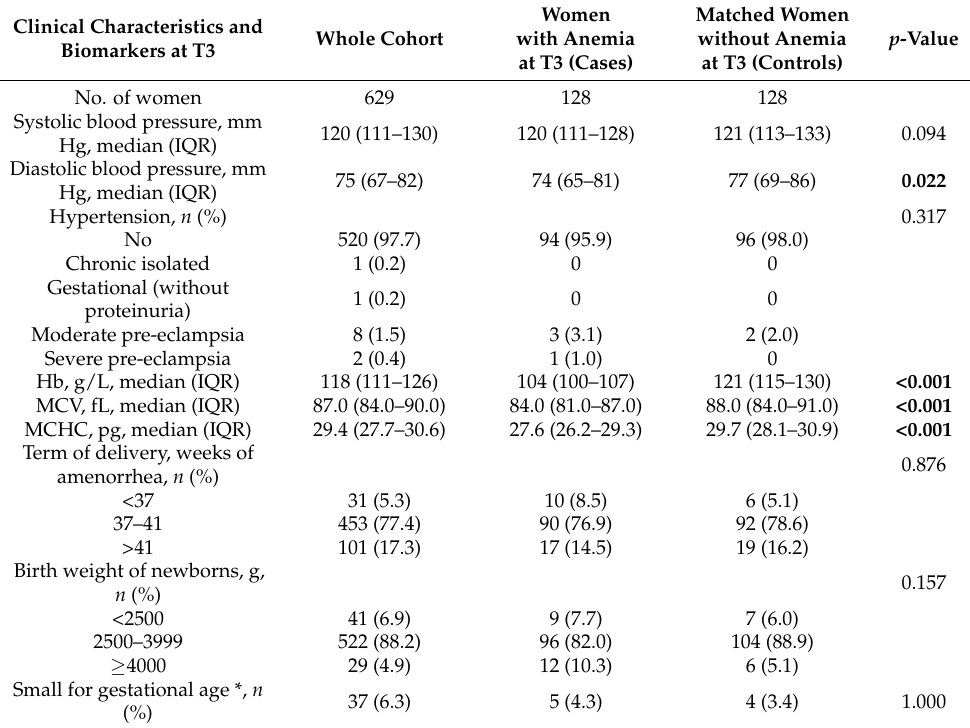
Table 2. Clinical characteristics and biomarkers at third trimester of pregnancy (T3) of pregnant women of the whole cohort, women with anemia at T3 (cases), and women without anemia at T3 (controls).